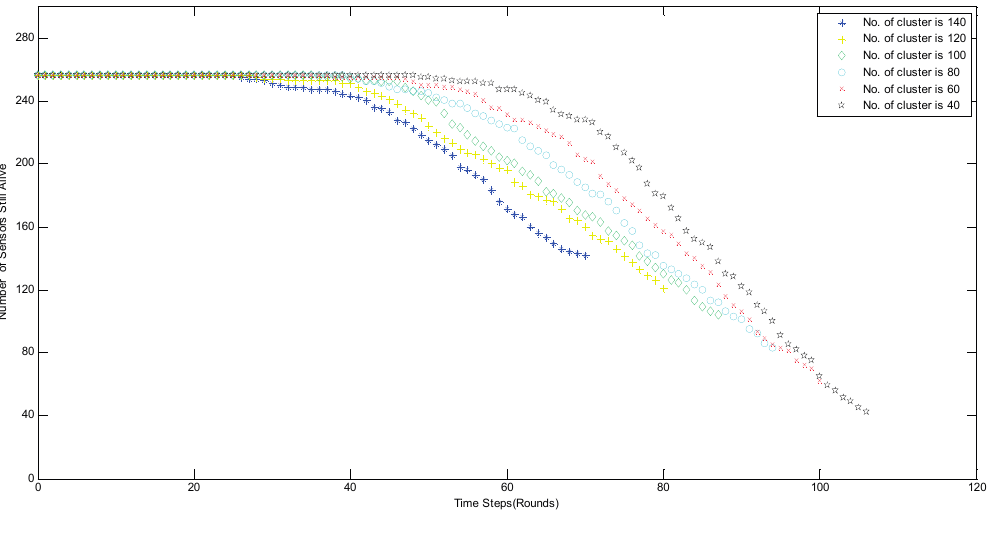
Figure 13. Lifetime of WSNs under different